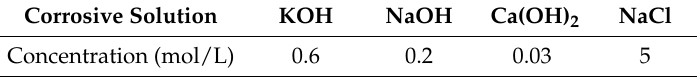
Table 2. Corrosive soaking solutions for